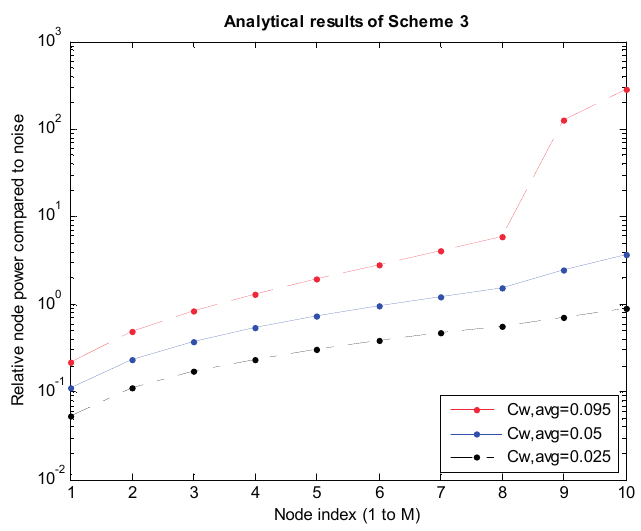
Figure 7. Power levels according to the node in Scheme 3.